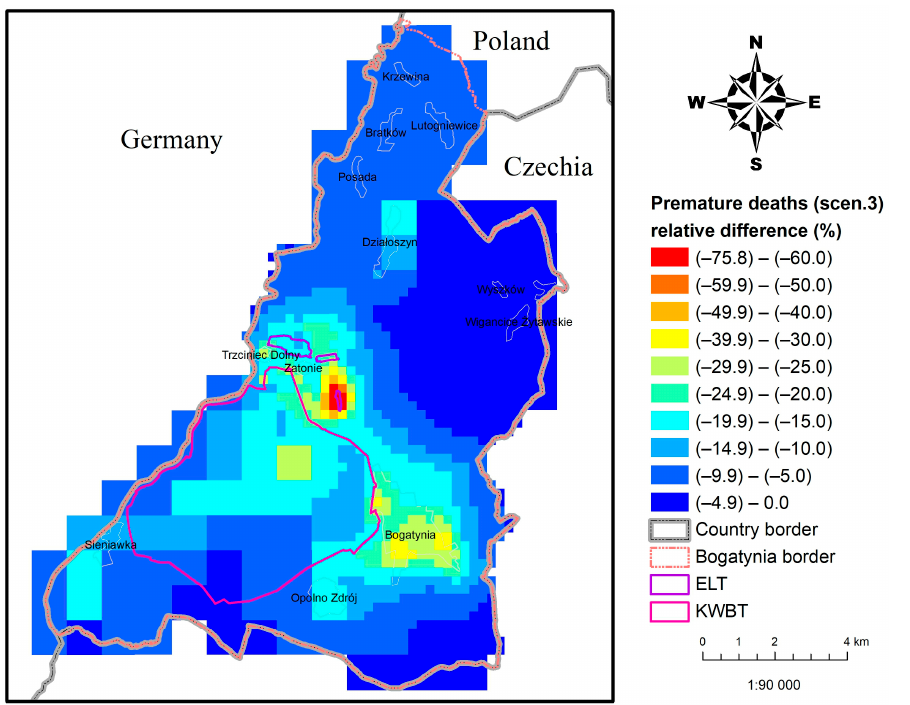
Figure 27. Spatial distribution of relative changes (reductions) in the number of premature deaths for scenario 2 relative to the baseline scenario.